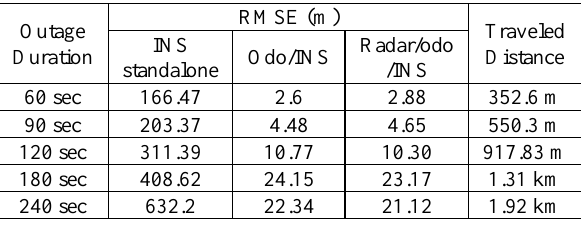
Table 2. Horizontal position RMSE for different GNSS signal outage durations for INS standalone, odometer/INS integration, and Radar/odometer/INS integration